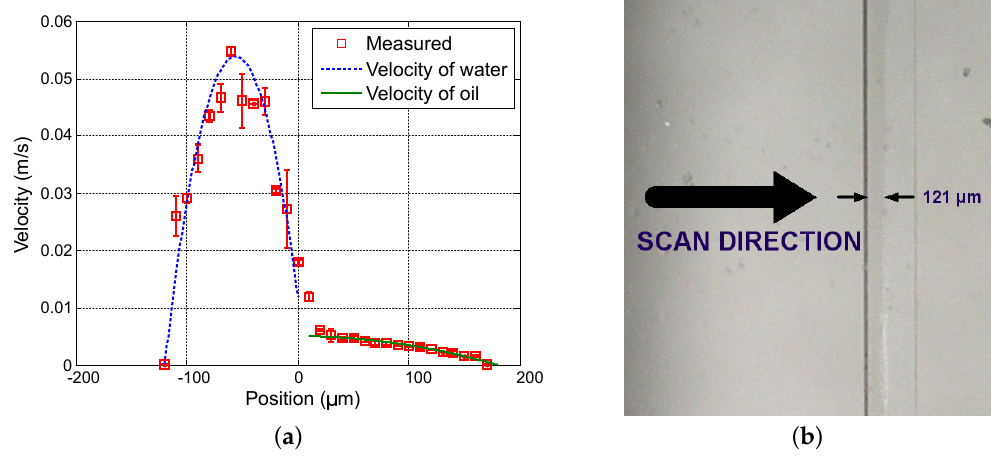
Figure 4. Experimental results for Q water = 20 µL · min − 1 and Q oil = 3 µL · min − 1 . ( a ) Measured profile (squares) and theoretical profile for water (dashed line) and for oil (solid line); and ( b ) reference image of the main channel with indication of the interface location.